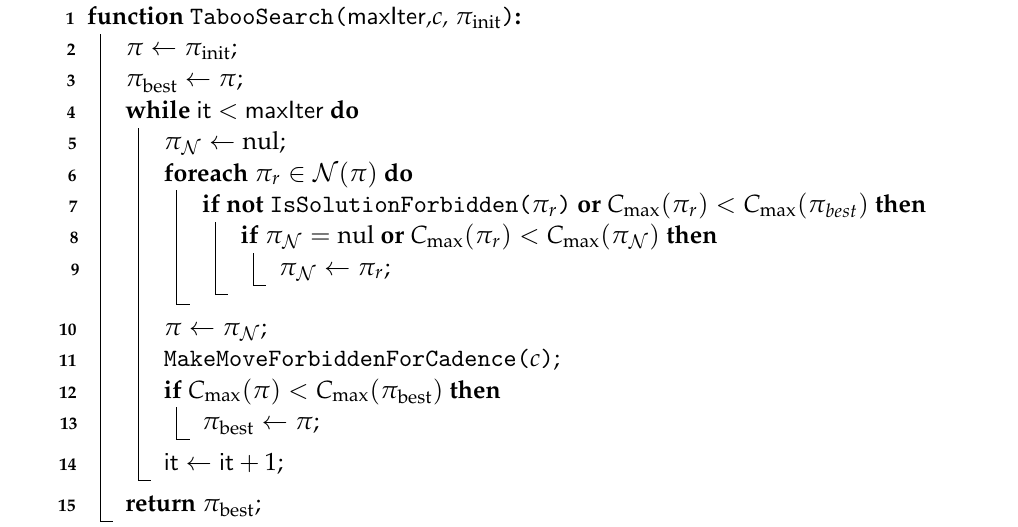
Algorithm 2: Taboo search (method